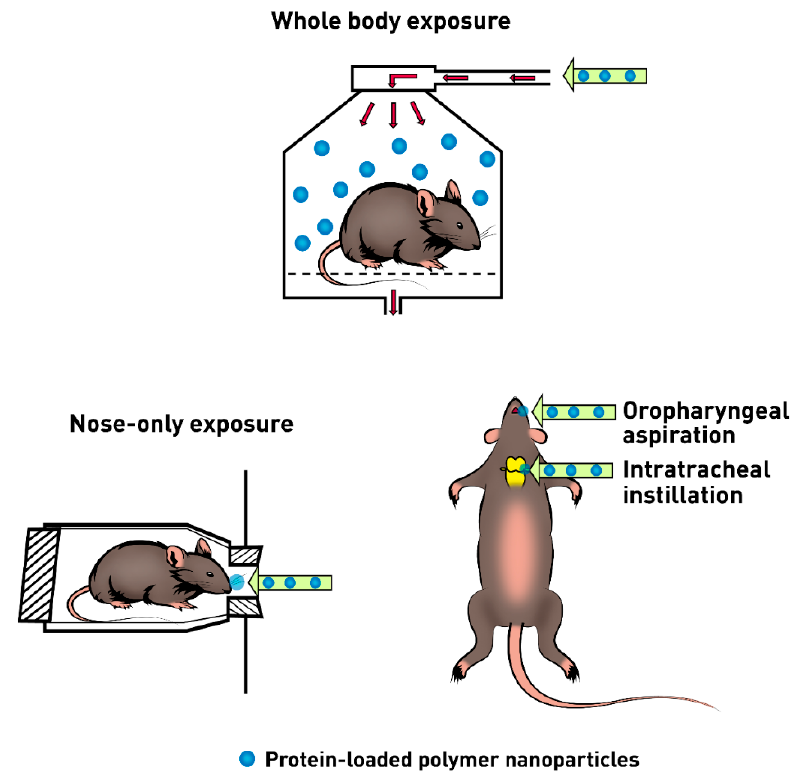
Figure 4. In vivo methods for protein-loaded nanoparticles pulmonary administration in small rodents.